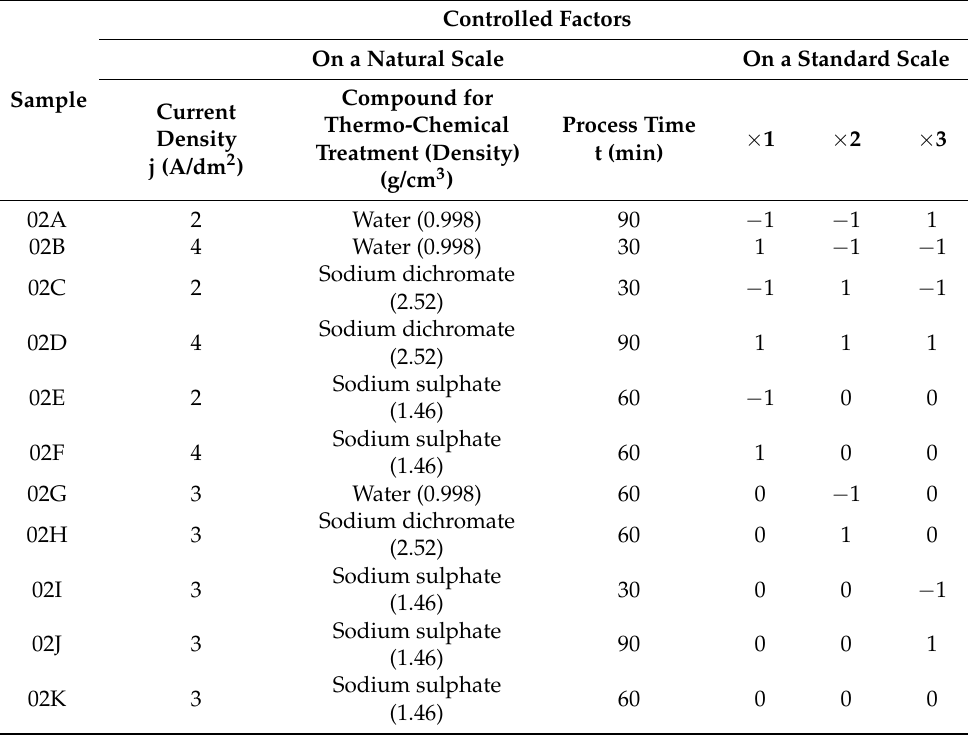
Table 2. Hartley’s plan for layers with thermo-chemical